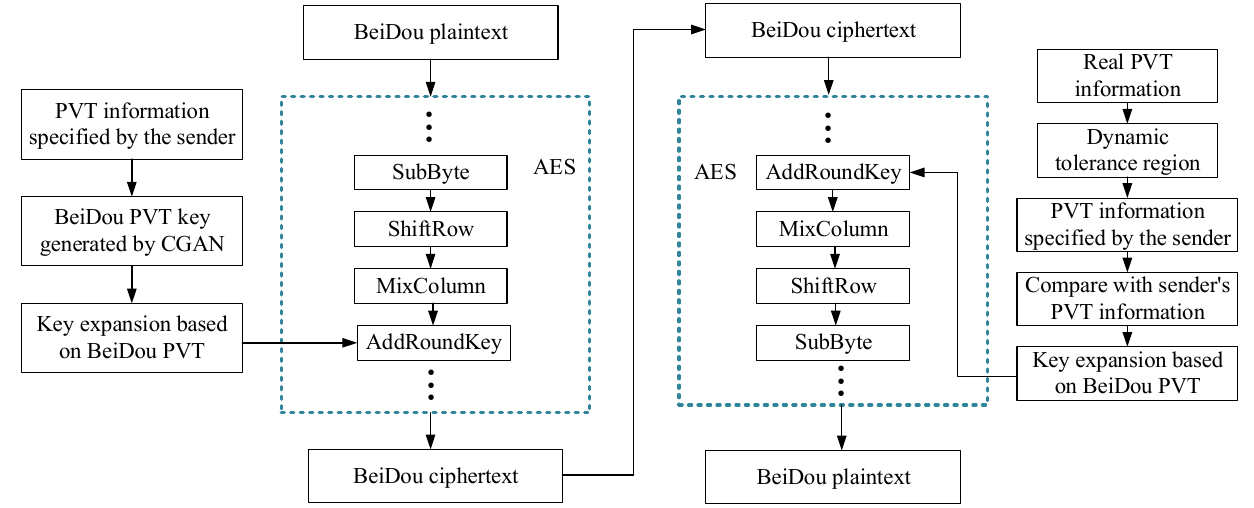
Figure 7. Flowchart of the encryption and decryption processes.